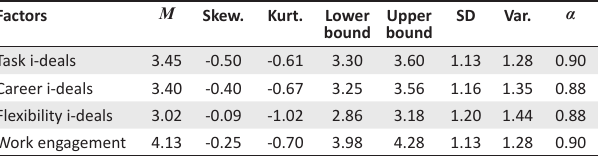
TABLE 1: Descriptive analysis of idiosyncratic deals and work engagement . Factors M Skew. Kurt. Lower